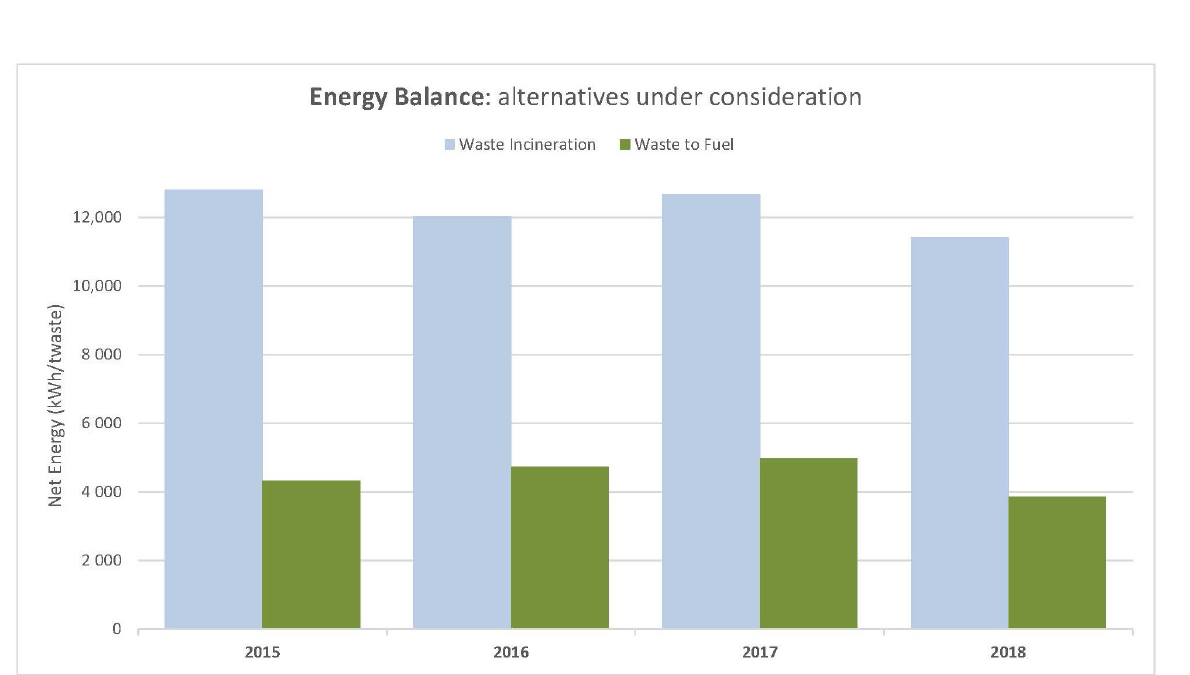
Figure 4. Graphical representation of the two alternatives